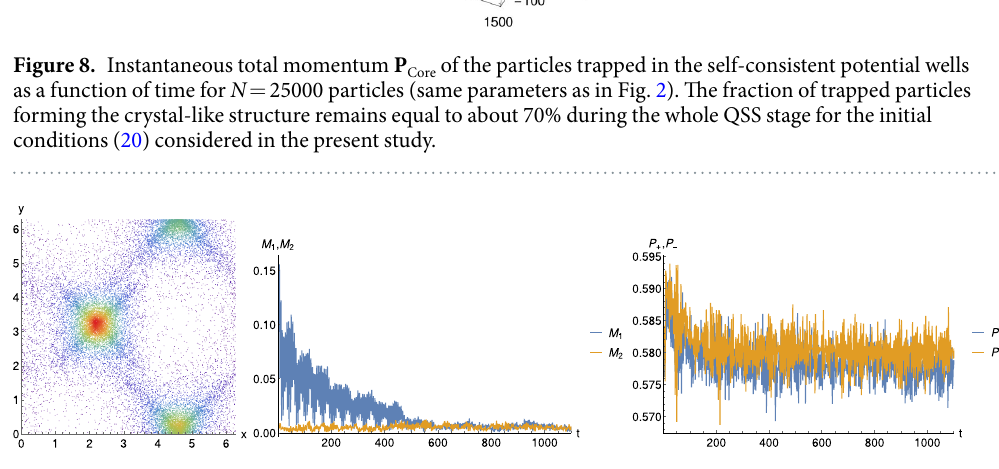
Figure 9. (left) Density plot in the ( x , y ) space at the time of the perturbation: the left core is displaced along the x -axis by Δ x = 0.8; The resulting time behaviours of the mean-fields (center) M 1 ( t ), M 2 ( t ) and (right) P + ( t ) and P − ( t